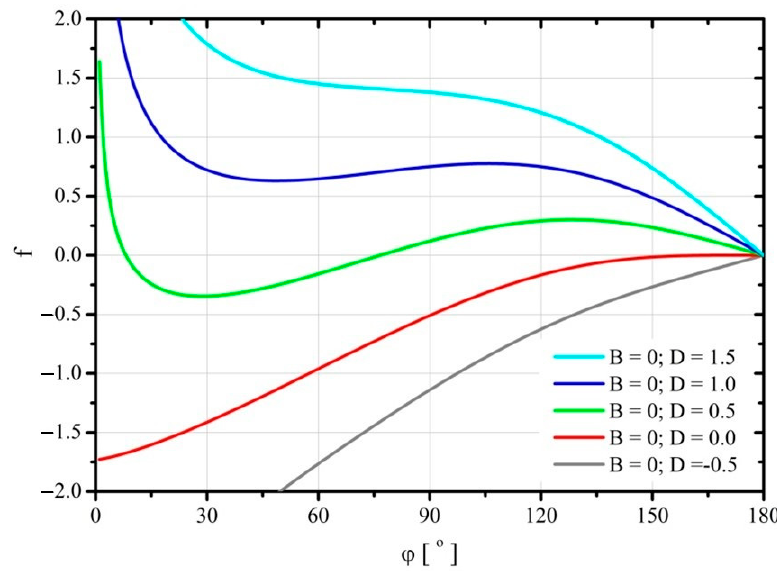
Figure 3. Change of the dimensionless free energy of the system during spreading of the droplet for the parameter 𝐵 = 0 .